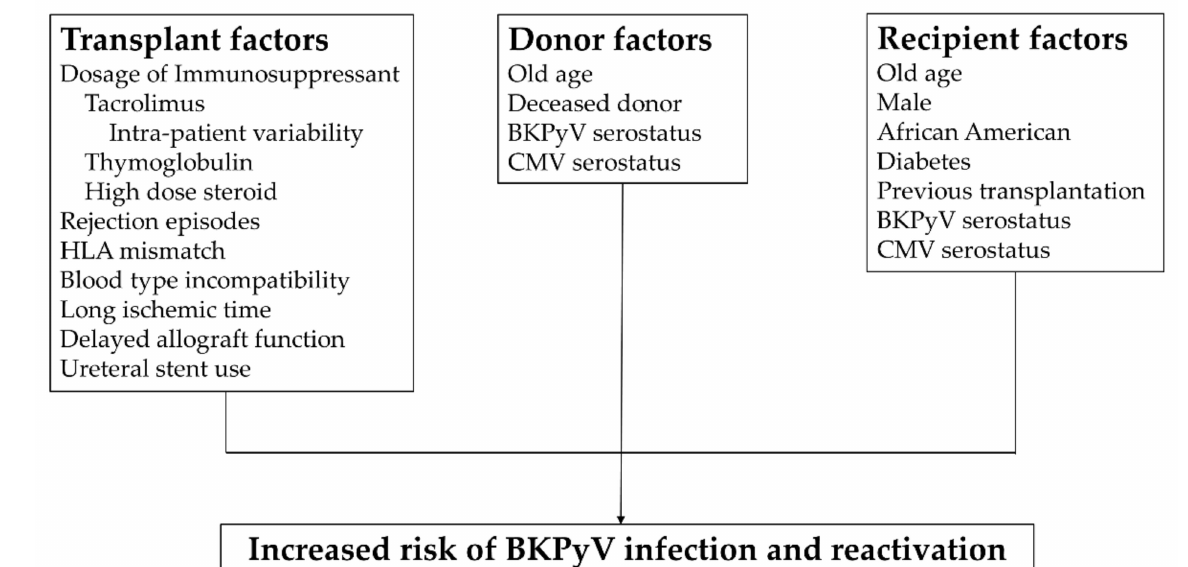
Figure 2. Risk factors for BKPyV infection. Risk factors can be assorted into 3 categories: Transplant factors [39,56,62–65,67,68,70–72], donor factors [16,18,62,64,66,69], and recipient factors [16,18,56,64,69]. Understanding risk factors that affect before and after transplant can be helpful in immune balance. Abbreviations: HLA, human leukocyte antigen; BKPyV, BK polyomavirus; CMV,